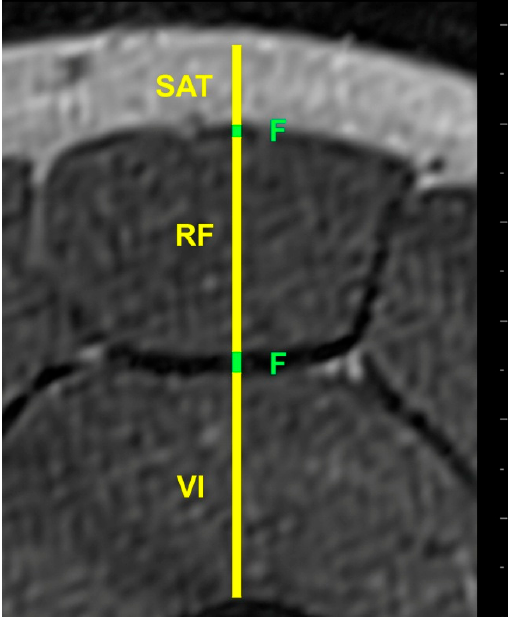
Figure 4. MRI image of the anterior thigh of the same participant; SAT = subcutaneous adipose tissue, F = Fascia, RF = Rectus Femoris muscle, VI = Vastus Intermedius muscle.